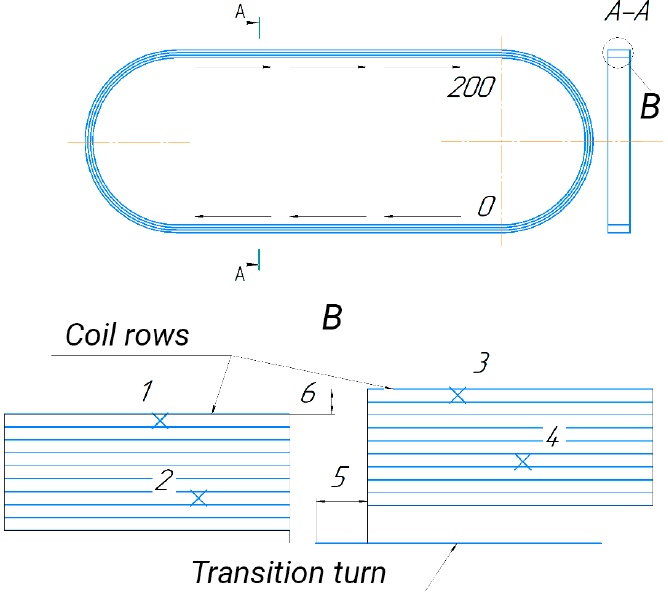
Figure 6. Layout of measurements on slices of tomograms. In view B, the lines show HTS tapes; the distances between them are increased for clarity.